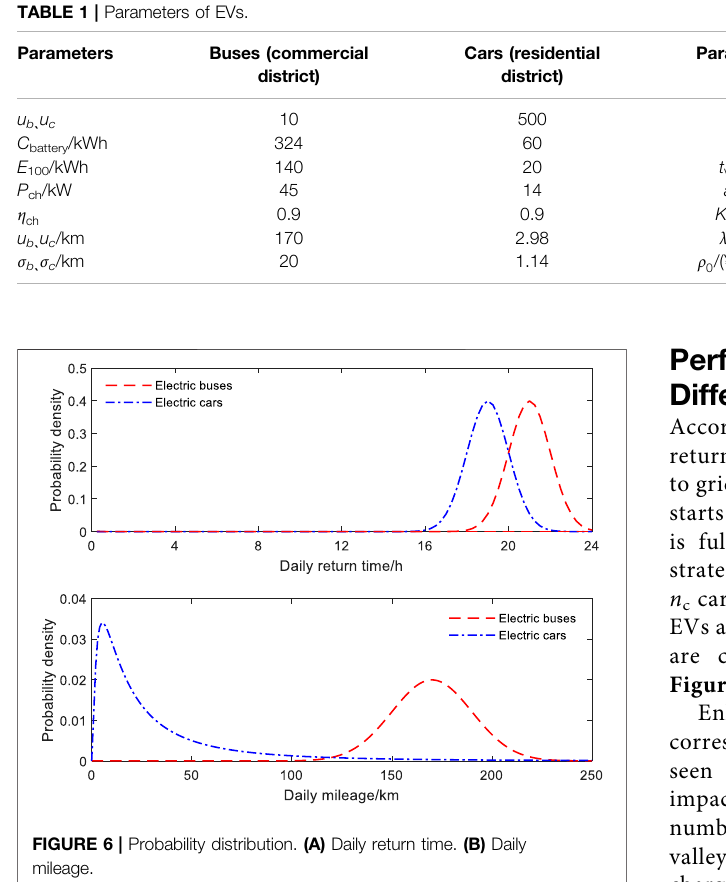
Table 1 , the probability distributions of daily return time and daily mileage of buses and cars are shown in Figure 6 .